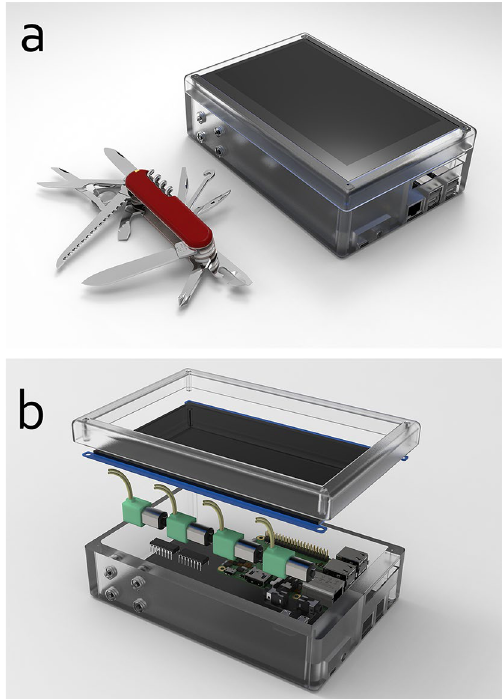
Figure 7. Render images of the 3D CAD model of the system with a plastic case. The system has a size of 12 × 18 × 5.5 cm (W × L × H). ( a ) A side-by-side size comparison of the system with a Swiss Army knife (91 mm model) in real-world size. ( b ) Exploded view showing the parts required for building the system, including a port extension board needed to use this case. The interconnections/cablings are not shown in this rendered